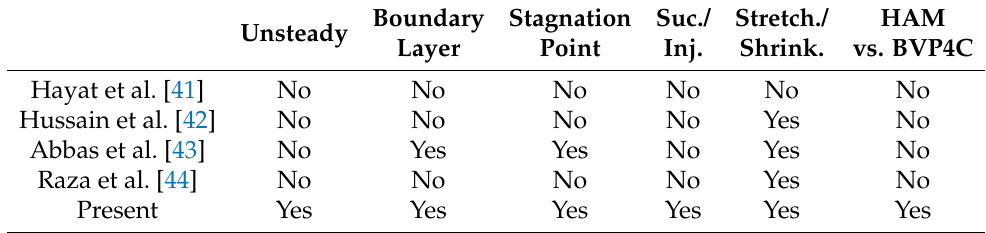
Table 1. Present study in comparison to studies in the literature. Boundary Stagnation Suc./ Stretch./ Unsteady